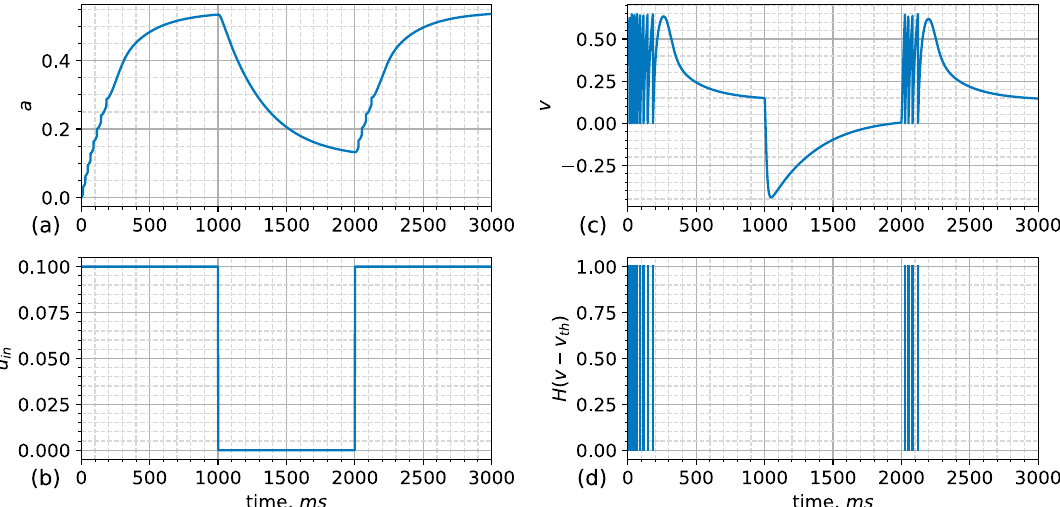
Figure 3. Adaptive exponential neuron (2) under rectangular input pulses: dynamics of ( a ) the adaptation variable a ( t ), ( b ) the injected input current u in , ( c ) the membrane potential v ( t ), and ( d ) the resulting spike sequence determined by the Heaviside step function H ( x ). The control parameters are given in Table